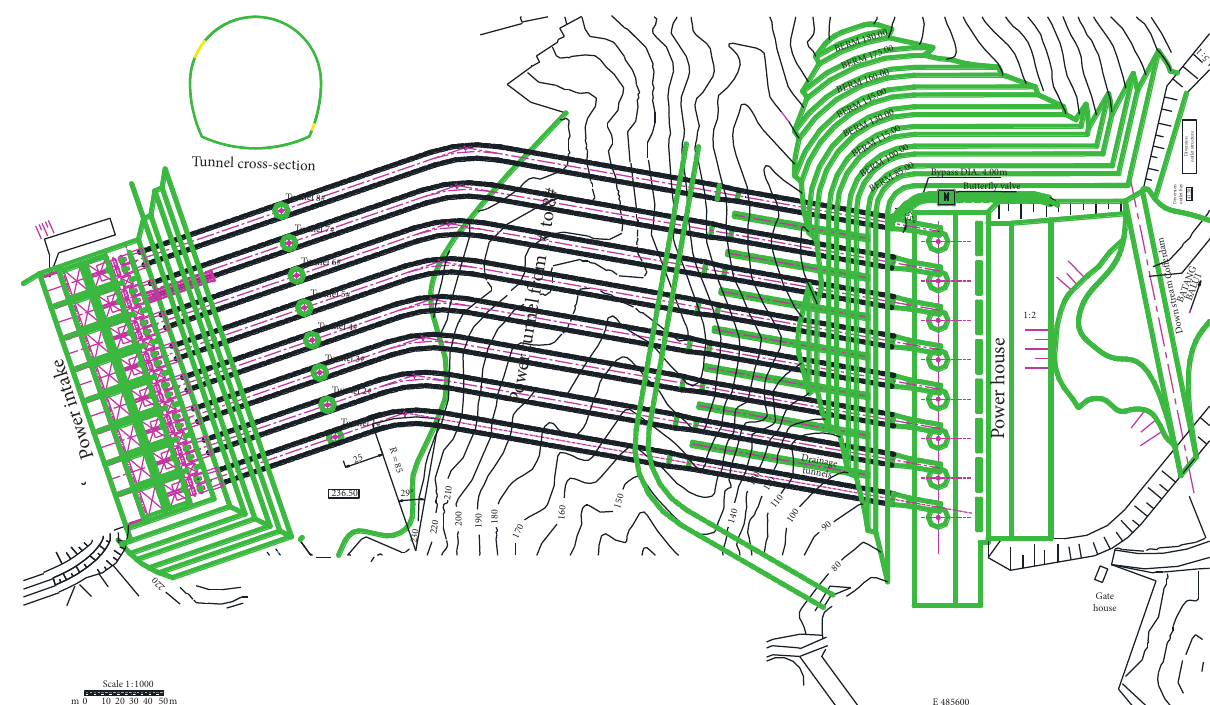
Figure 1: Layout of 8 power tunnels in the Bukun hydropower station and tunnel cross-section.